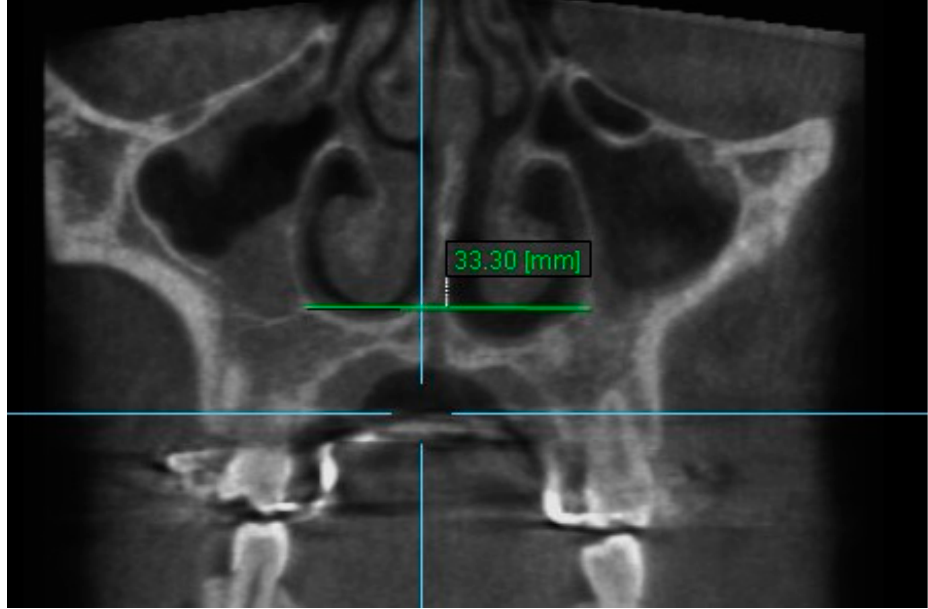
Figure 10. Nasal Floor 8. 9. Nasal Floor 9: The distance between the junction of anatomical floor of nasal cavity and the medial aspect of the floor ipsilateral sinus on coronal slice through the center of root of the central incisors (Figure 11).